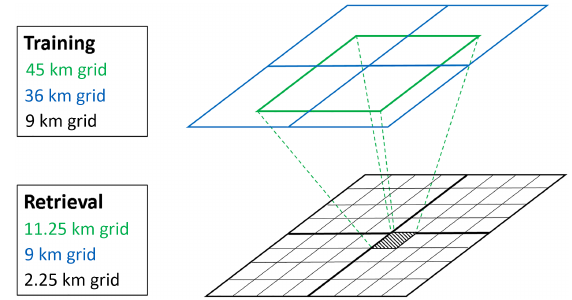
Figure 1. Two levels of spatial grids used for training and retrieval steps in the NN algorithm. While both steps have similar grid struc- tures, the spatial resolutions are different as listed